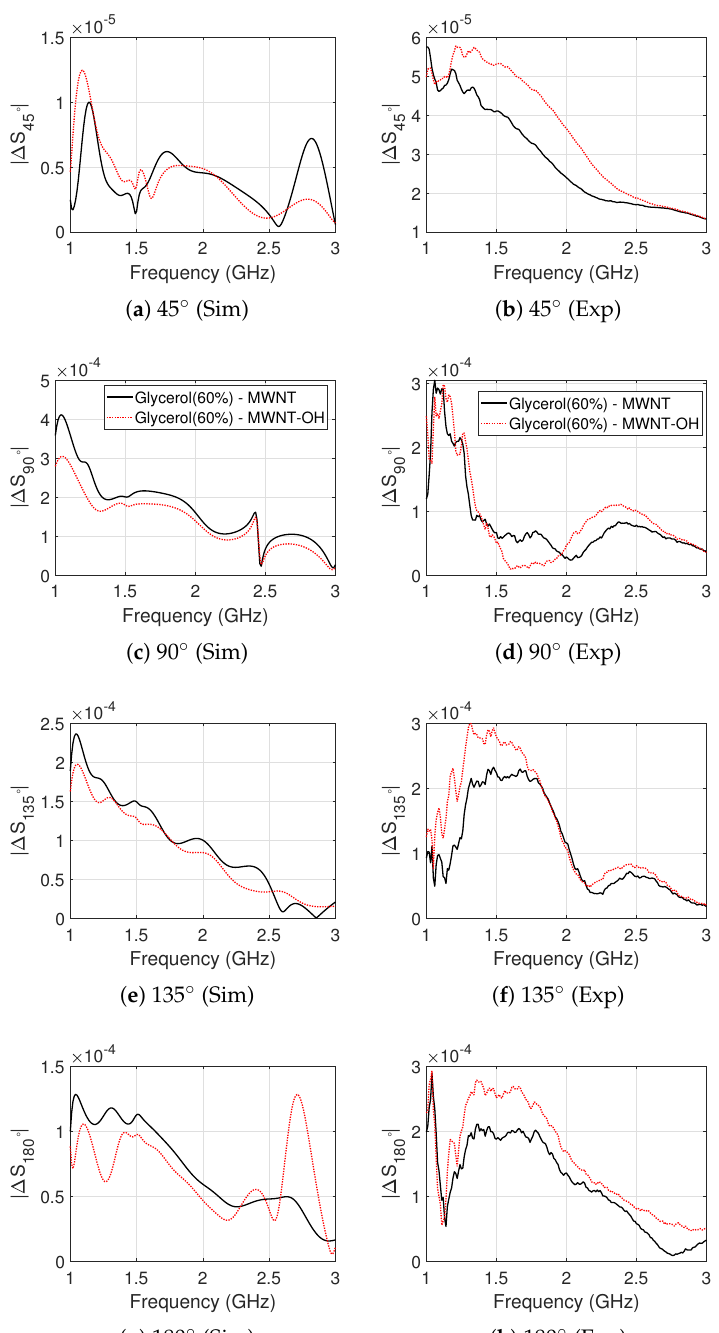
Figure 6. Difference in received signal strength between “no-target” and “target T1” cases, plotted for each receiver position against frequency. T1 is filled with MWNT and MWNT-OH colloidal suspensions with a concentration of 2 mg/mL dispersed in 60% glycerol. The simulated ( left ) and experimental ( right ) signal differences are plotted between 1.0–3.0 GHz, which is the operational frequency range for the employed